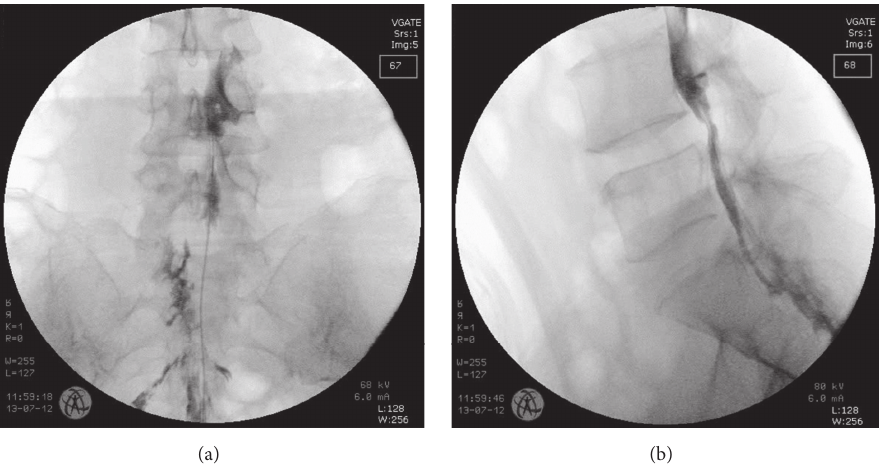
Figure 1: Fluoroscopic image of a patient receiving a percutaneous epidural adhesiolysis. Anteroposterior view (a) and lateral view